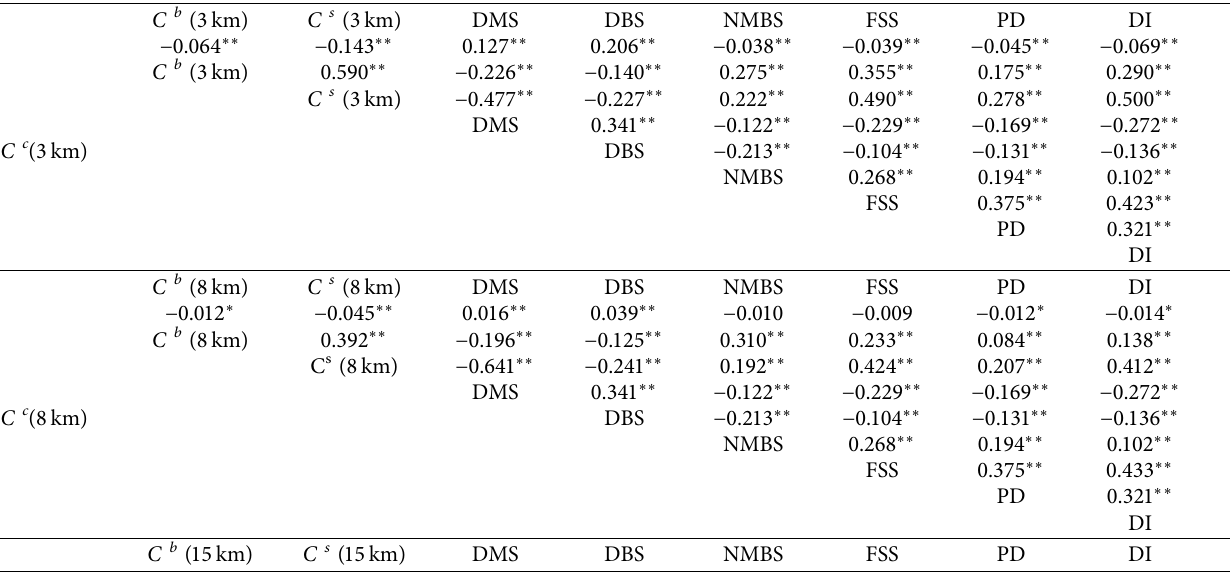
Table 3: Correlation matrix of indicators of independent variables at multiscales.